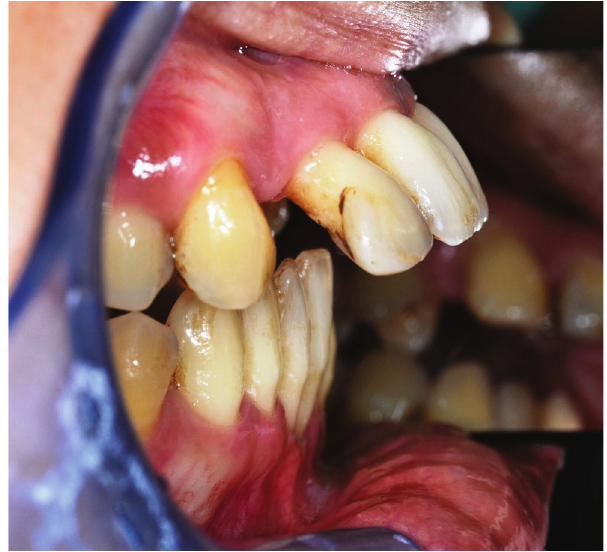
Figure 3: Clinical case: lateral